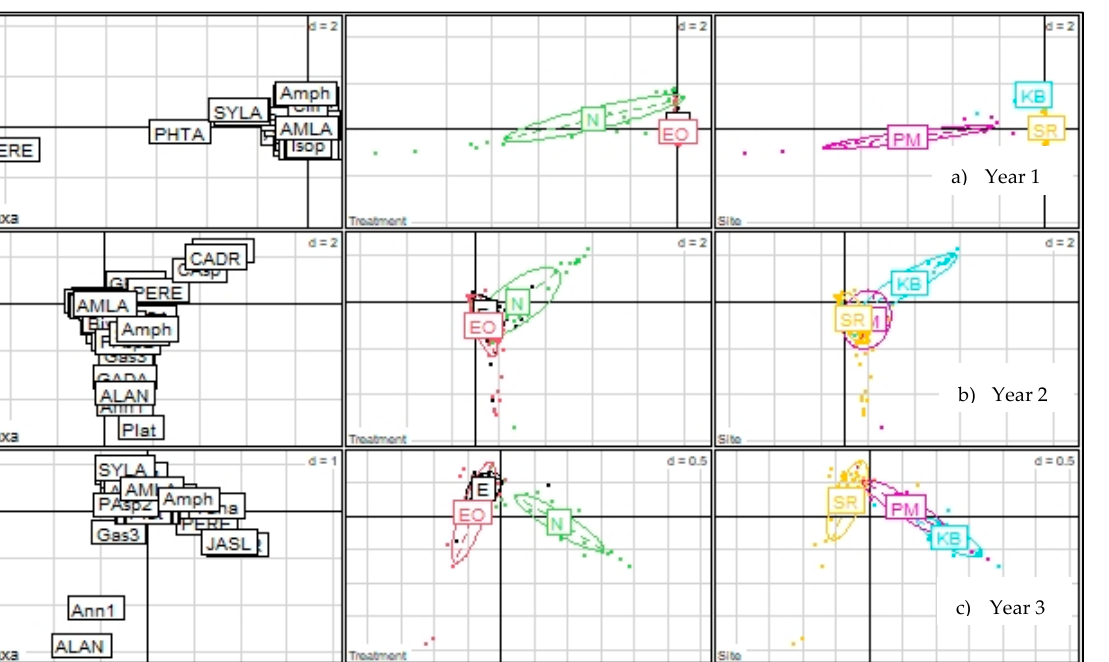
Figure 4. Correspondence analysis of taxa detected from shoot samples from restored eelgrass within eelgrass only (E) and eelgrass and oyster combination plots (EO), and natural (N) eelgrass populations. Samples collected at natural sites Keller Beach (KB, n = 36) and Point Molate (PM, n = 41), and restored populations at the San Rafael project site (SR, n = 365) across three years of post-treatment sampling. Panels show taxa ( left ) coded by treatment ( center ) and site ( right ), with ( a ) all taxa included: Adonis (Bray–Curtis) p < 0.001; Correspondence Analysis (ade4) Factors 1 and 2, Inertia 21.93% and ( b ) Pentidotea resecata [PERE], Phyllaplysia taylori [PHTA], and Platyhelminthes [Plat] removed to spread results. Ado-